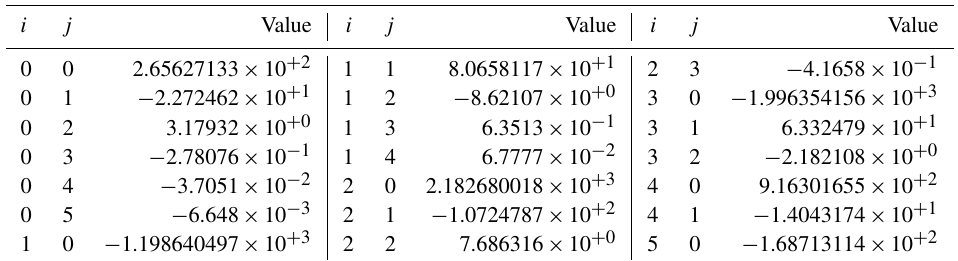
Table 4. Values of the coefficients a i,j of Eq. (13).